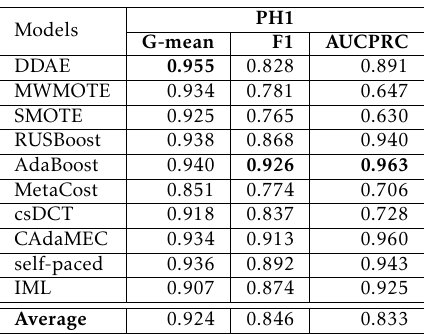
Table 9. Overall Results for PH1 Dataset